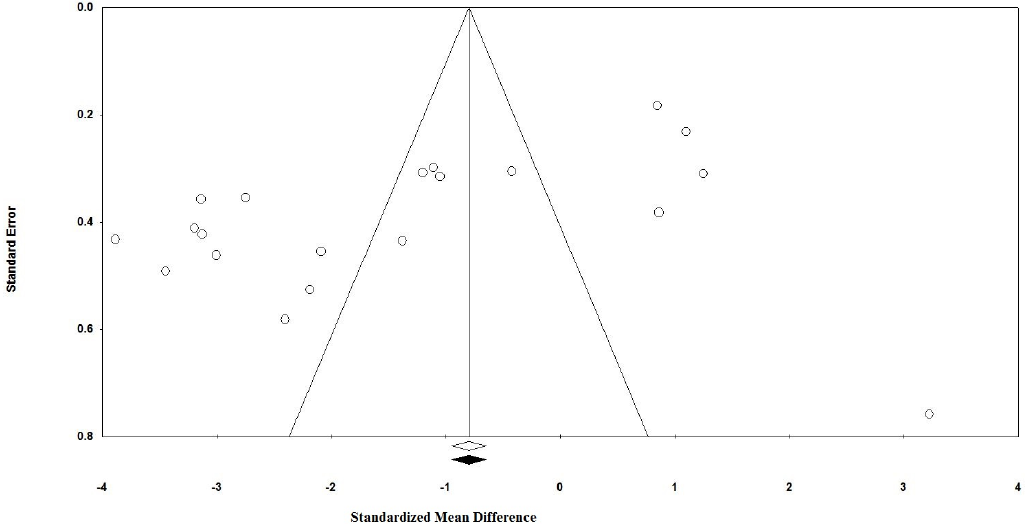
Figure 4. Trim and fill method was used to impute for potentially missing studies, no potentially missing study was imputed in funnel plot. Open circles represent observed published studies; open diamond represents observed effect size; closed diamond represents imputed effect size.